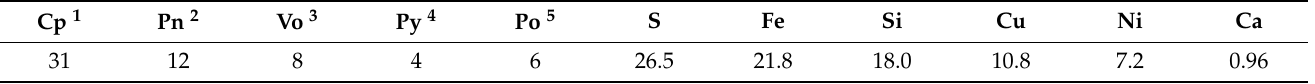
Table 1. Content of main elements and sulfide minerals (wt%) in bulk copper–nickel